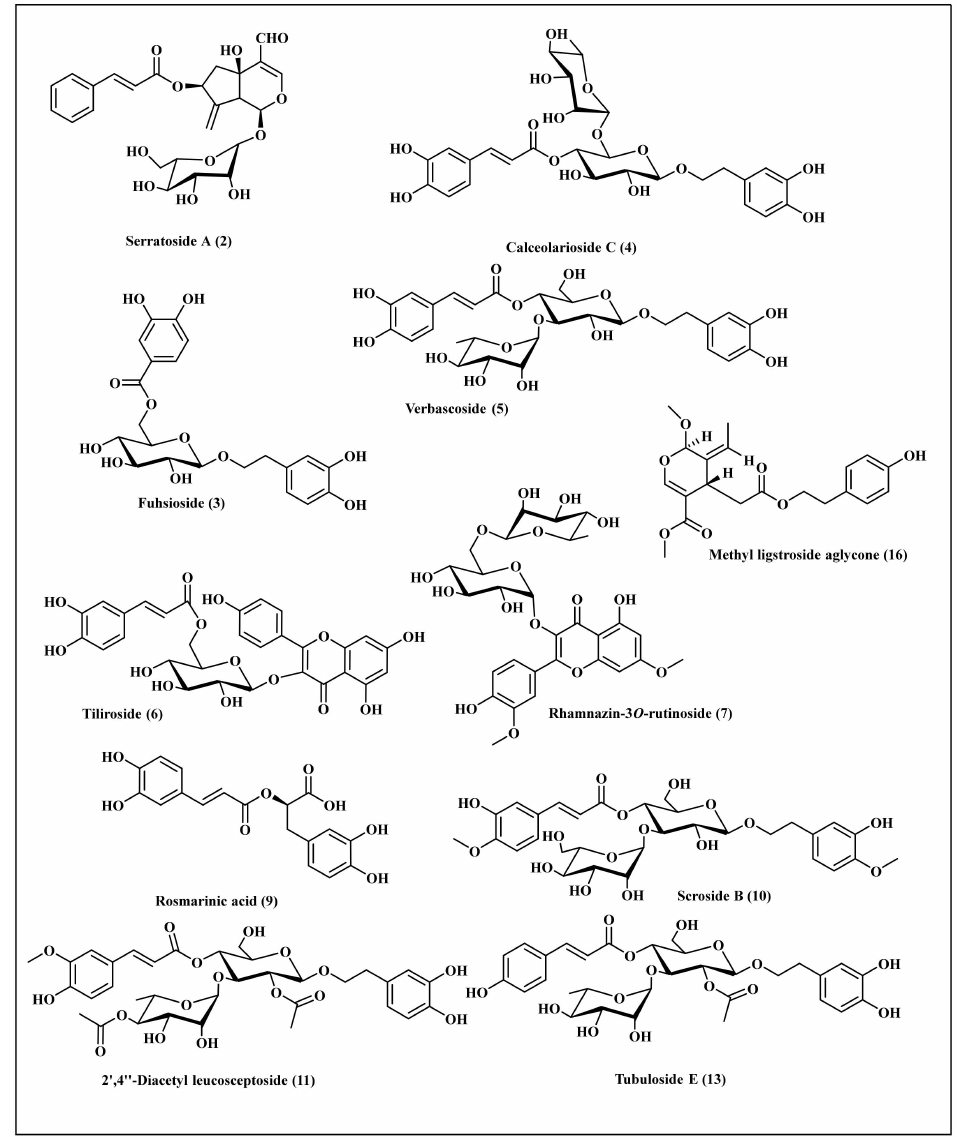
Figure 4. Major compounds tentatively identified in the total methanol extract of leaves from C. speciosum using HPLC-ESI-MS/MS in the negative ion